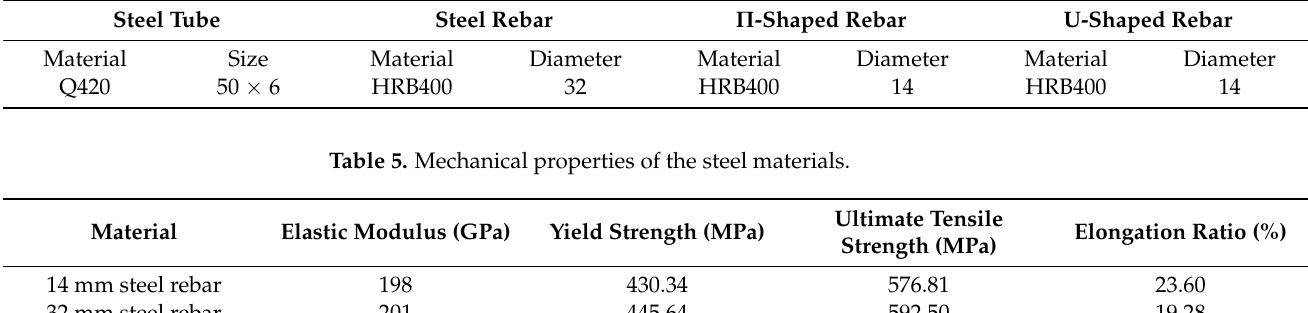
Table 4. The specific types of steel materials in numerical simulation (Unit: mm). Table 5. Mechanical properties of the steel materials.